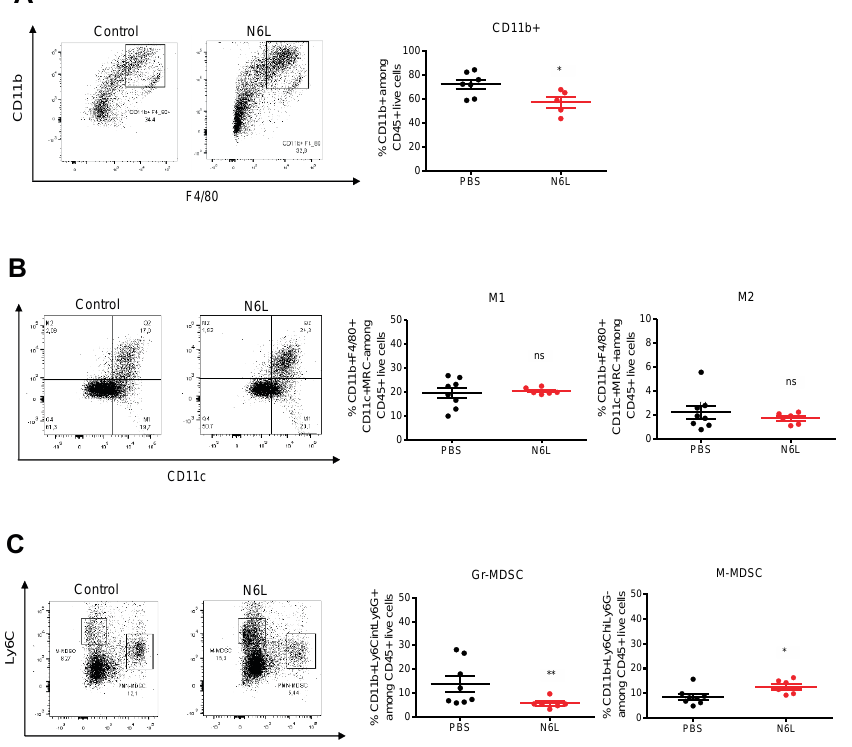
Figure 2. N6L impacts myeloid cell infiltration in mPDAC tumours. Myeloid cells infiltrated in control or N6L-treated tumours were analysed by flow cytometry. ( A ) Frequency of CD11b + myeloid cells of control and N6L-treated tumours. ( B ) Tumour-associated macrophages were analysed by flow cytometry and the % of M1 (CD45 + CD11b + F4/80 + CD11c + MRC - ) and of M2 (CD45 + CD11b + F4/80 + CD11c − MRC + ) macrophages of control and N6L-treated tumours were plotted as indicated. ( C ) Myeloid suppressor cells (MDSCs) were analysed by flow cytometry, and the % of Gr-MDSCs (CD11b + Ly6G + Ly6C low ) and of M-MDSCs (CD11b + Ly6G − Ly6C hi ) were plotted as indicated. p -values were calculated between indicated conditions by two-tailed Mann-Whitney U-test (**, p < 0.01; *, p < 0.05; ns = not significant; n are indicated on graphs).